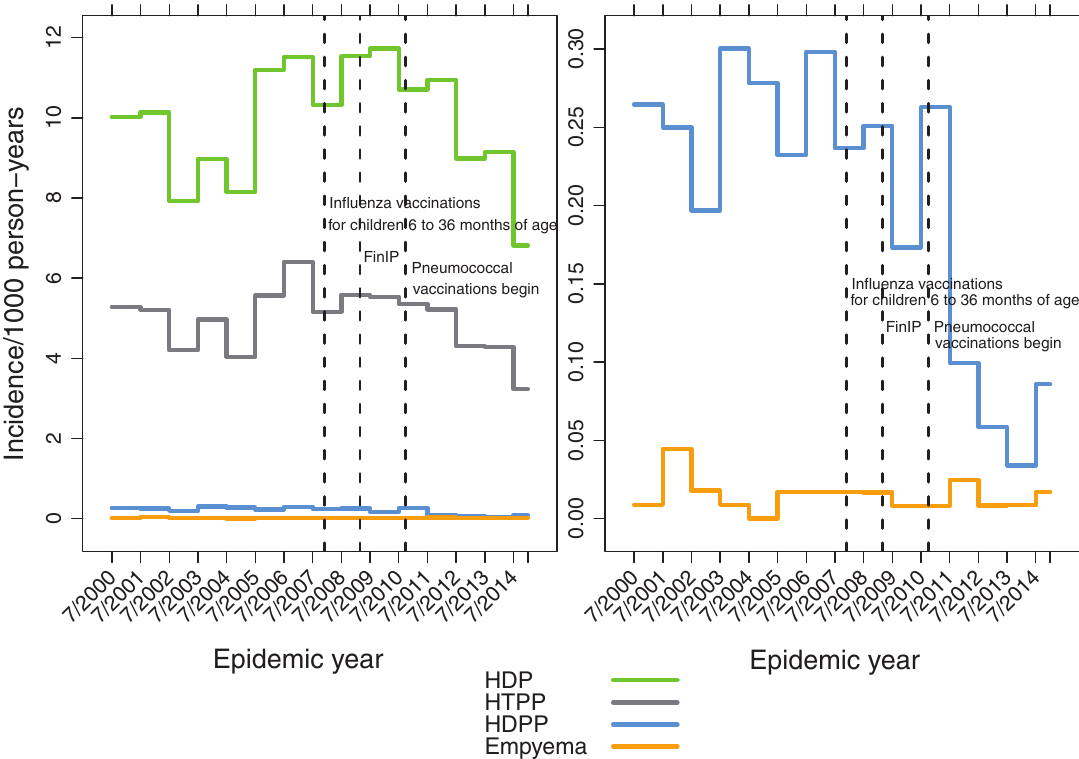
Fig 4. Annual pneumonia rates in children less than 2 years of age by epidemic years. A) all pneumonia outcomes, HDP hospital-diagnosedpneumonia,HTPP hospital-treated primary pneumonia, HDPP hospital-diagnosedpneumococcal pneumoniaand empyema; B) HDPP and empyema on different